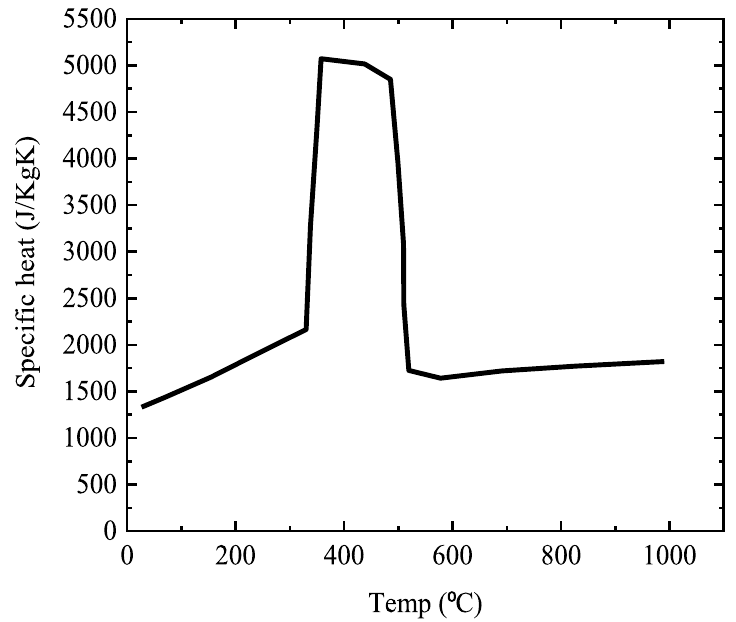
Fig. 27 Specific heat of GFRP bar